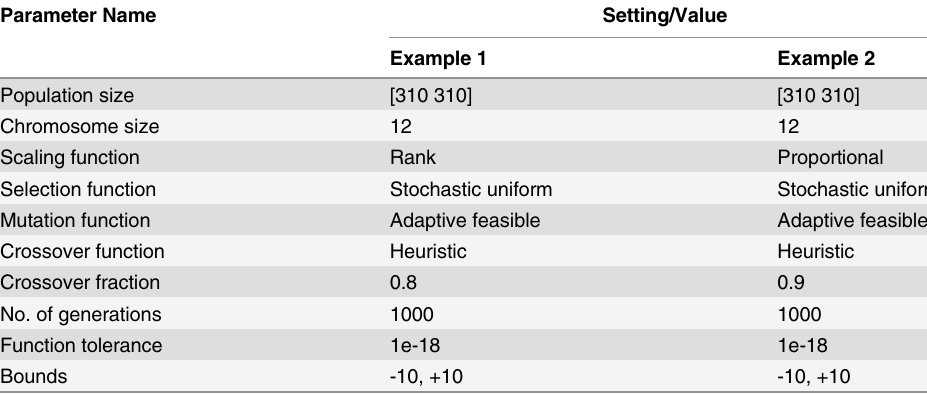
Table 1. Parameter settings and values for